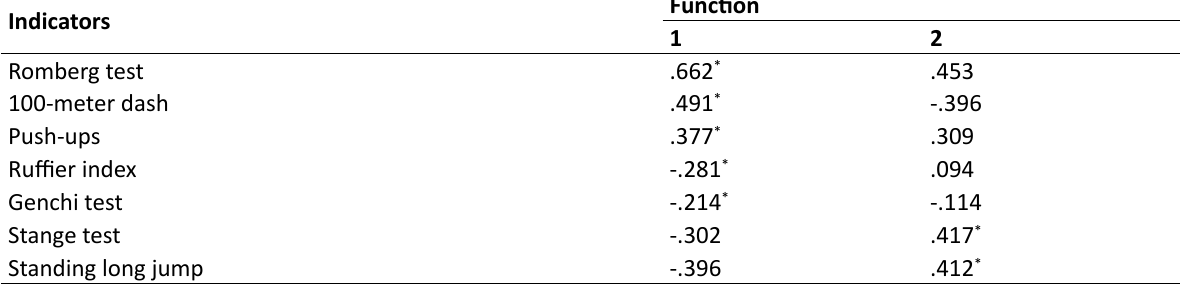
Table 11. Structure Matrix